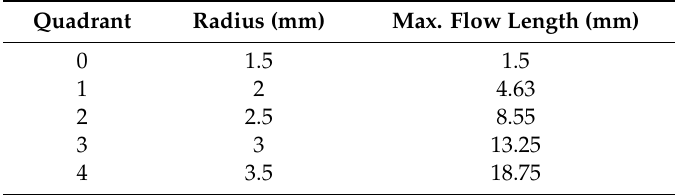
Table 1. Values of the flow length for different radii for the spiral with a 1 × 1 mm 2 cross section. Quadrant Radius